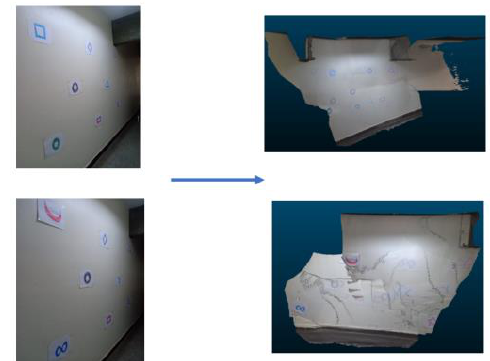
Figure 5. Effect of changing the layout of